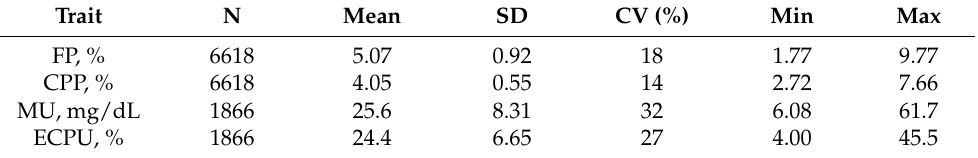
FP = fat percentage, CPP = crude protein percentage, MU = milk urea concentration, ECPU = efficiency of crude protein utilization.